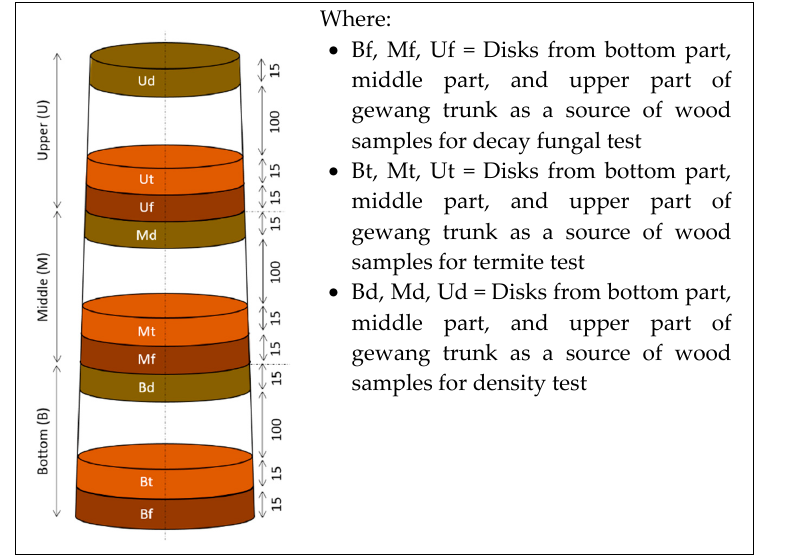
Figure 1. Cutting pattern of gewang log to prepare wood specimens representing bottom part ( B ), middle part ( M ), and upper part ( U ) of the trunk.